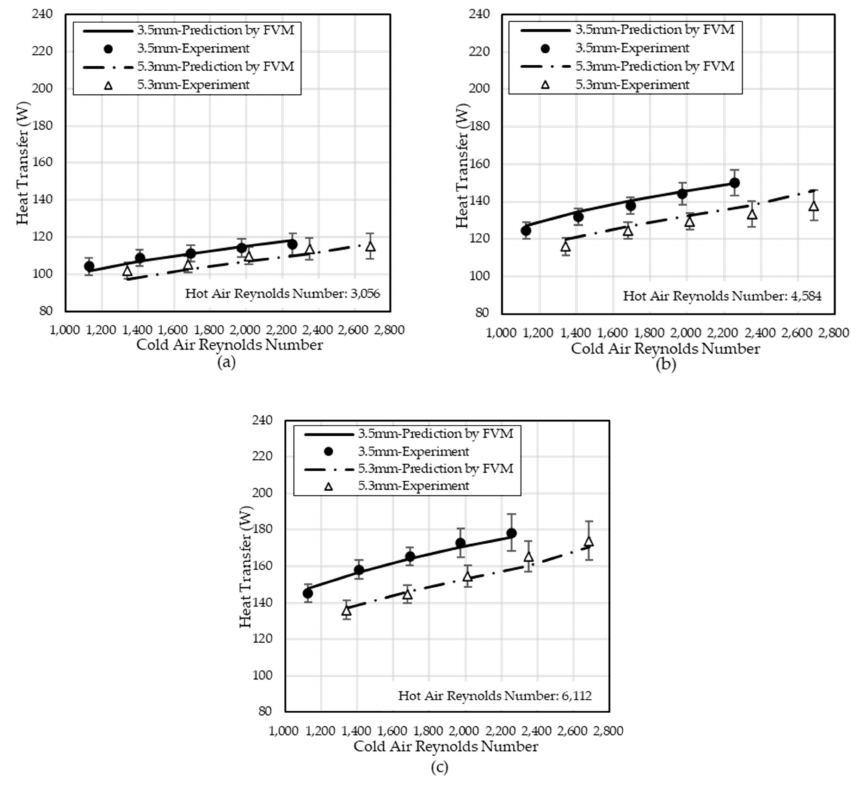
Figure 7. Experimental and numerical comparison of heat transfer in the heat exchanger at 3.5 and